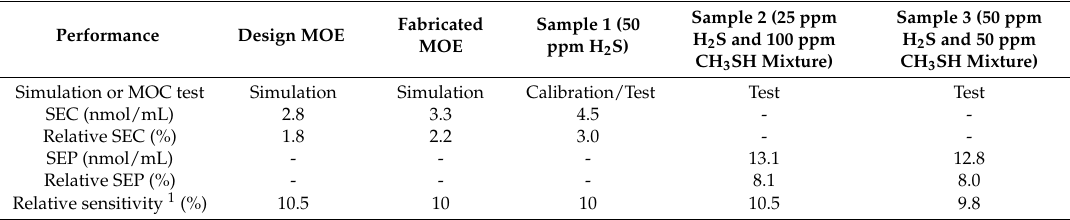
Table 1. Summary of MOE